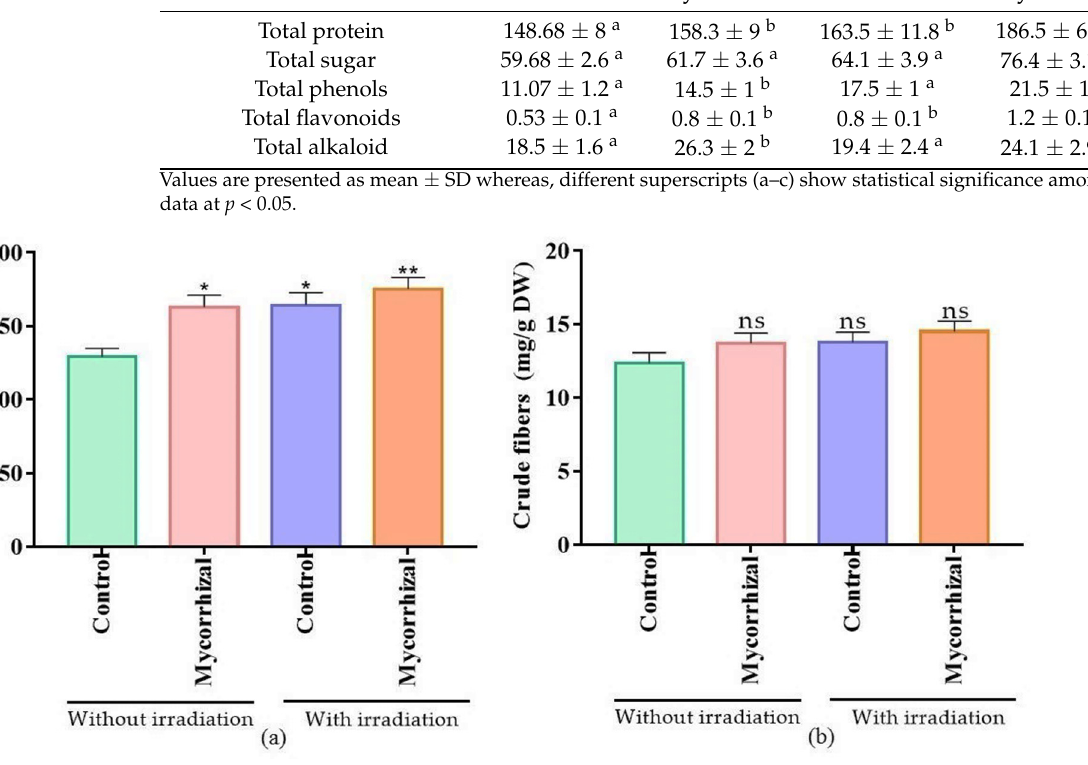
Figure 2. Effect of laser light and mycorrhizal co-treatment on plant ( a ) ash and ( b ) crude fibers content. Values are presented as mean ± SD whereas, * = p < 0.05, ** = p < 0.01, ns =